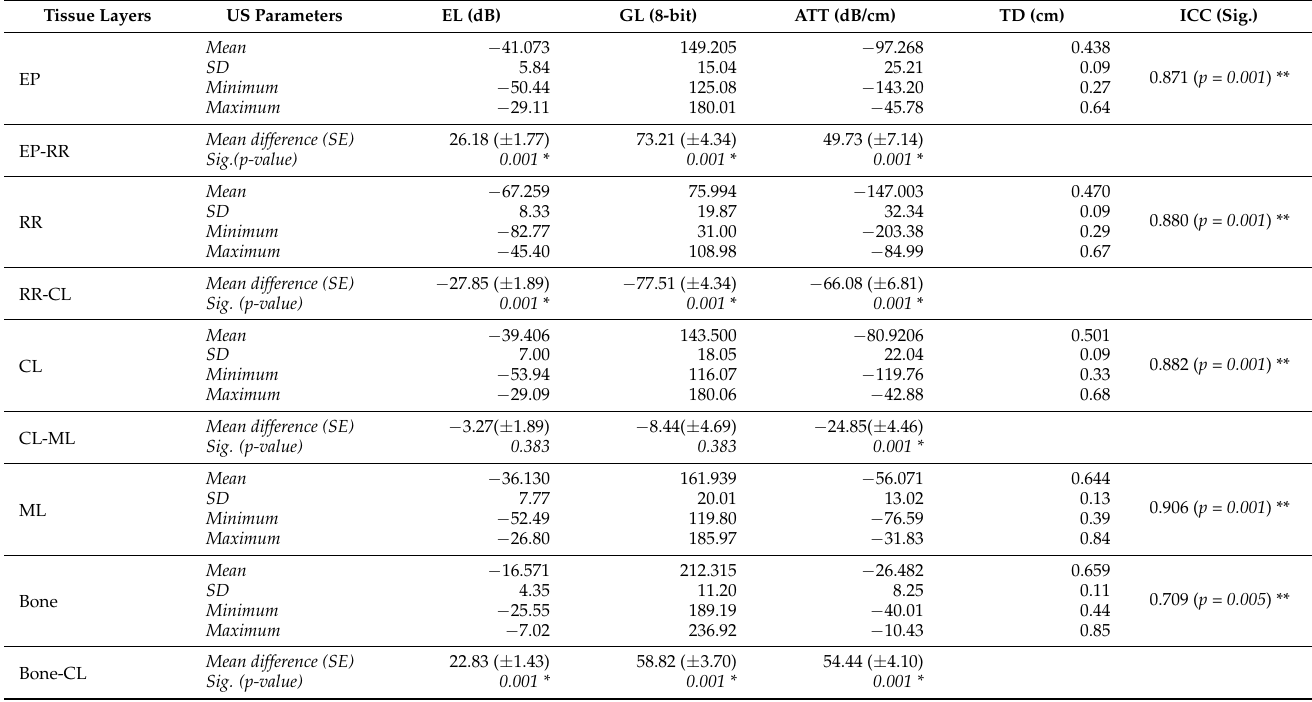
Table 2. Descriptive statistics of quantitative ultrasound